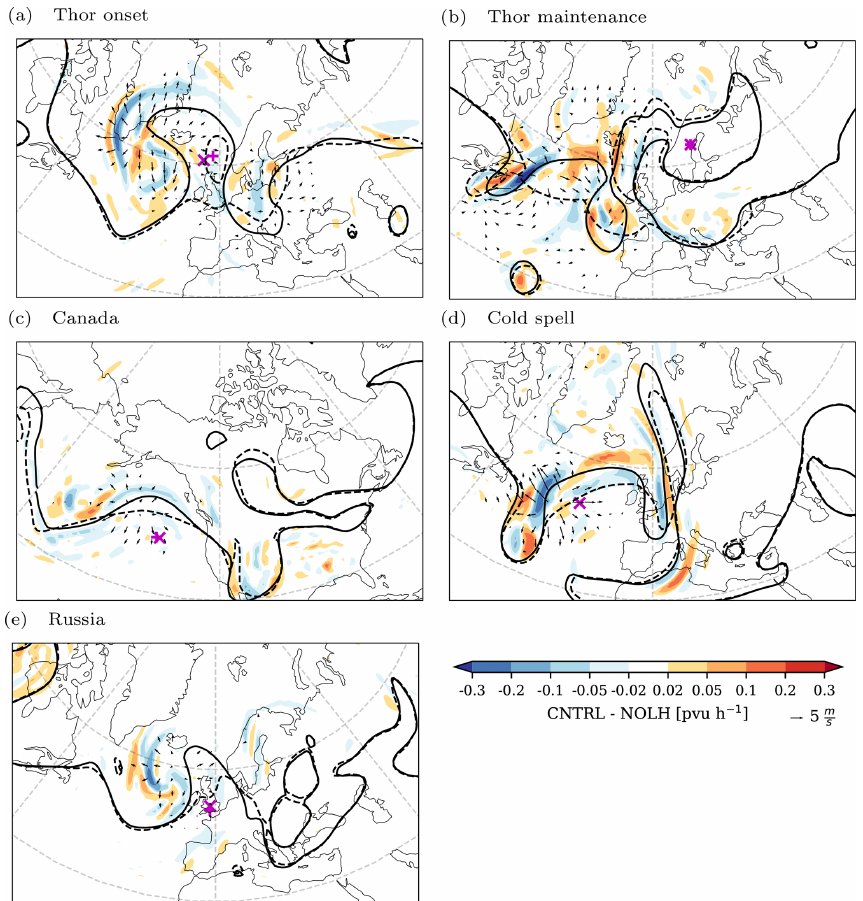
Figure 9. Difference (CNTRL–NOLH) in upper-level PV advection by the divergent (irrotational) wind ( v χ ·∇ PV, shaded in potential vorticity units per hour), difference in upper-level divergent wind (vectors only shown for wind speed larger than 1ms − 1 ), and upper-level 2pvu contour (solid for CNTRL, dashed for NOLH) after 3d model simulation for (a) Thor onset, (b) Thor maintenance, (c) Canada, (d) Cold spell, and (e) Russia. “x” and “ + ” show locations of blocking centers for CNTRL and NOLH,